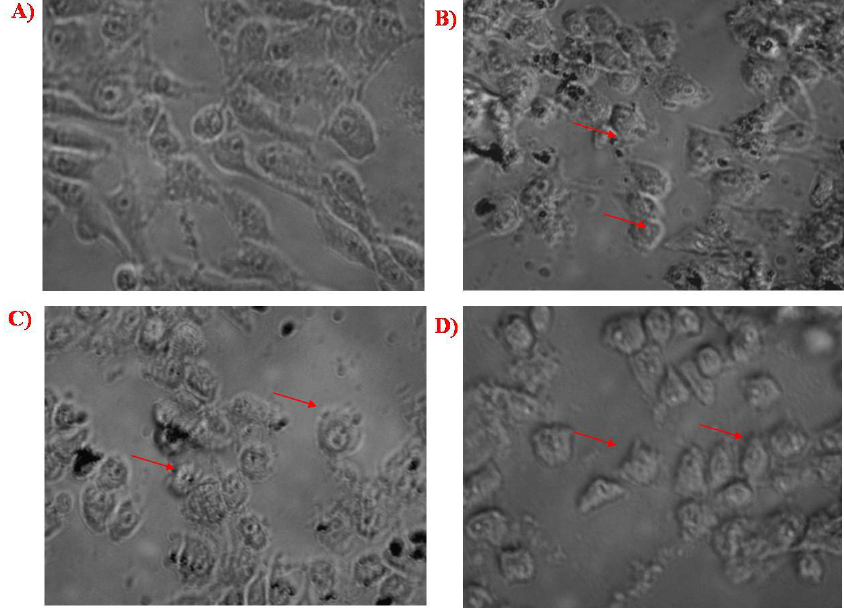
Figure 9. ( A ) Control cells, ( B ) cells treated with biosynthesized SeNPs, ( C ) cells treated with chi- tosan-modified SeNPs, and ( D ) cells treated with